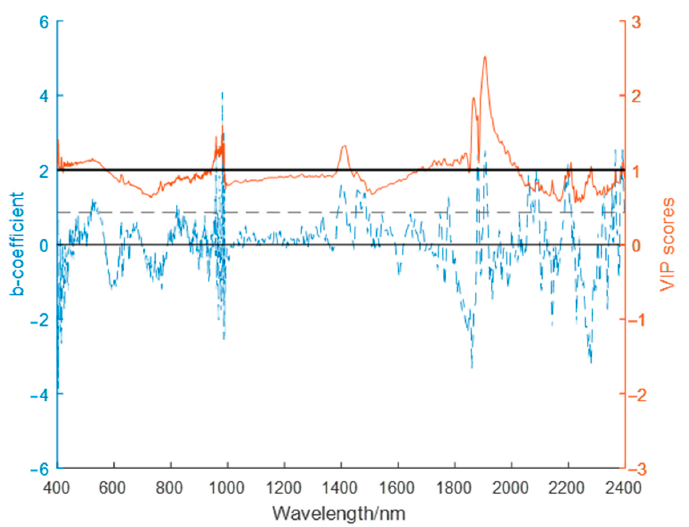
Figure 5. Regression coefficients and VIP scores of the PLS model based on NSS Cd .